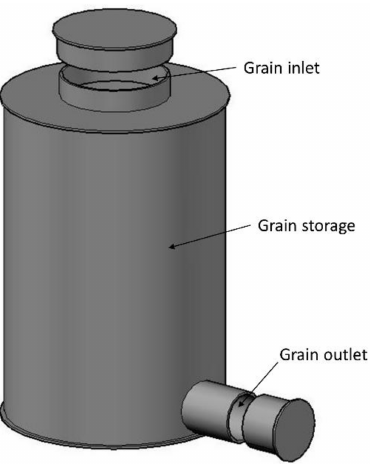
Figure 2. Metal silos used for grain storage in developing